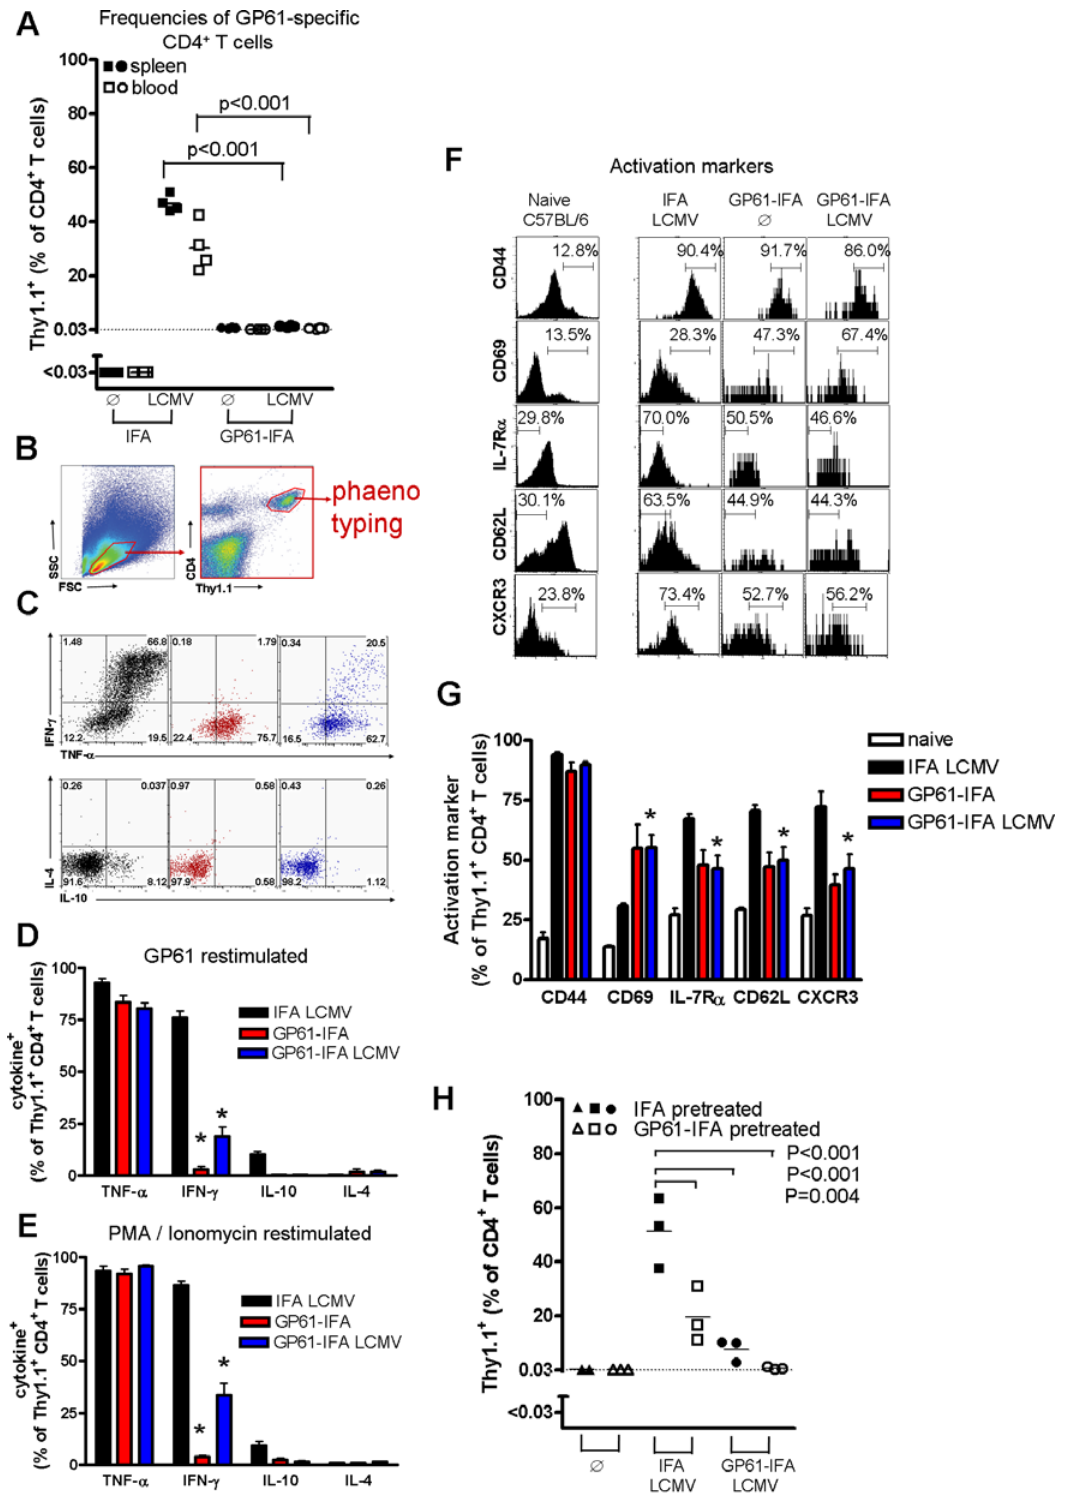
Figure 1. Peptide tolerisation leads to functional impairment of virus-specific CD4 + T cells. A–G: 5 6 10 4 splenocytes from mice transgenic for a T cell receptor recognizing the LCMV helper epitope GP61 (LCMV-glycoprotein 61-80 /I-A b -specific TCR, SMARTA mice) and expressing the T cell marker Thy1.1 were adoptively transferred into C57BL/6 mice on day -10. One group of mice was treated with 100 m g GP61 dissolved in IFA (squares), while control mice were treated with IFA alone (circles) at days -9, -6, -3. At day 0 mice were infected with 200pfu LCMV-WE or left untreated. Seven days after infection mice were analyzed for CD4 + T cell function. (A) Frequencies of GP61-specific CD4 + T cells (Thy1.1 + T cells) were analysed in spleen and blood. (B) For further phenotyping of thy1.1 + CD4 + cells, cells were gated as shown in the gating tree. (C) Cells were re-stimulated with GP61 in vitro and after six hours Thy1.1 + T cells were analysed for intracellular expression of IL-4, IL-10, IFN- c and TNF- a by FACS analysis (one of four representative dot blots is shown. (D) Bar charts show data analyzed in C (n=4,*p , 0.001). (E) Cells were re-stimulated with PMA/Ionomycin in vitro and after six